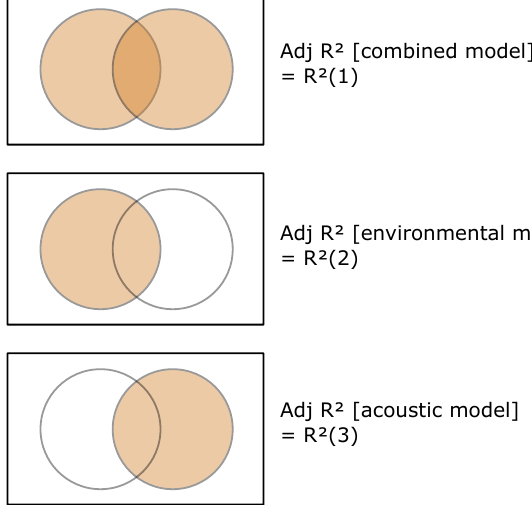
Figure 2. Venn diagrams representing the partition of the variation of a response variable (i.e., a descriptor of fish assemblage structure) between the two sets of explanatory variables (i.e., envi- ronment and acoustics). The rectangle represents 100% of the variation in the response variable. Common fraction is the intersection (not the interaction) of the variation explained by linear models of environment and